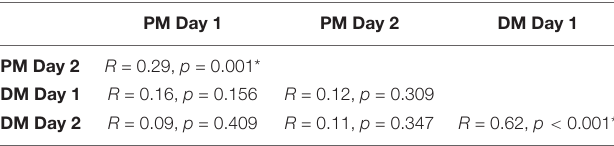
TABLE 2 | Correlation matrix of scaled performance on experimental tasks across days.